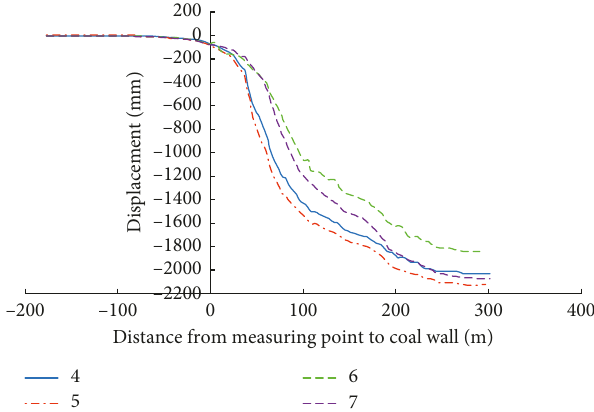
Figure 19: The displacement curves of the overlying strata at the second measuring line.